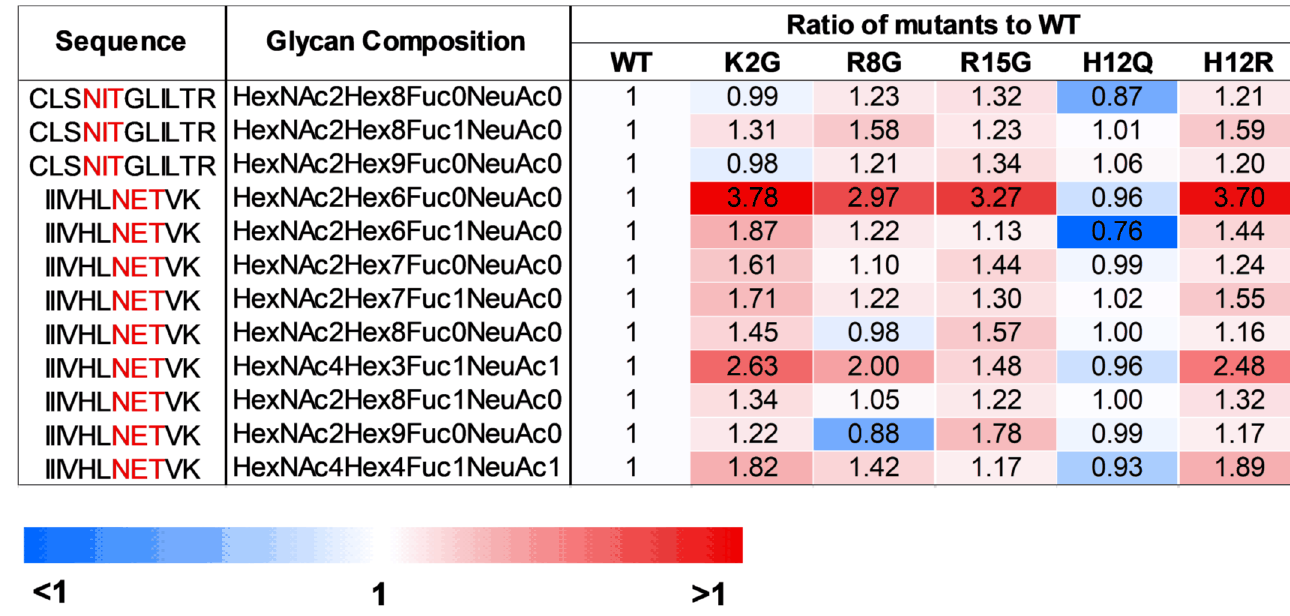
Fig 8. Proteomic and glycoproteomic analyses of virion proteins using liquid chromatography-tandem mass spectrometry (LC-MS/MS). Sucrose-pelleted virions were denatured with 8M in1 M ammonia bicarbonate buffer. The denatured proteins were than prepared for trypsin digestion at 37˚C overnight. The samples containing peptides were acidified pH = 3 and desalted using C18 SPE column. The C18 elute was dried in the speed-vac and then resuspended in 0.2% formic acid. The samples (1 μg) were then subjected to LC-MS/MS. Relative abundance of different glycoforms found on 2 identified glycopeptides from SP mutants vs WT were calculated and shown as ratio of mutant to